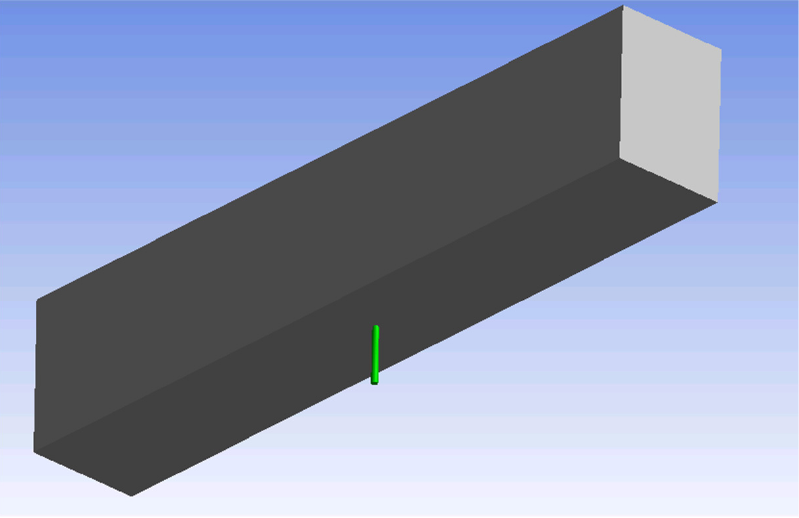
Figure 3. Anchors directly exposed to fire using 3D modelling in ANSYS [22]. Equation (2) describes the Neumann boundary condition satisfied at the fire- exposed surface: